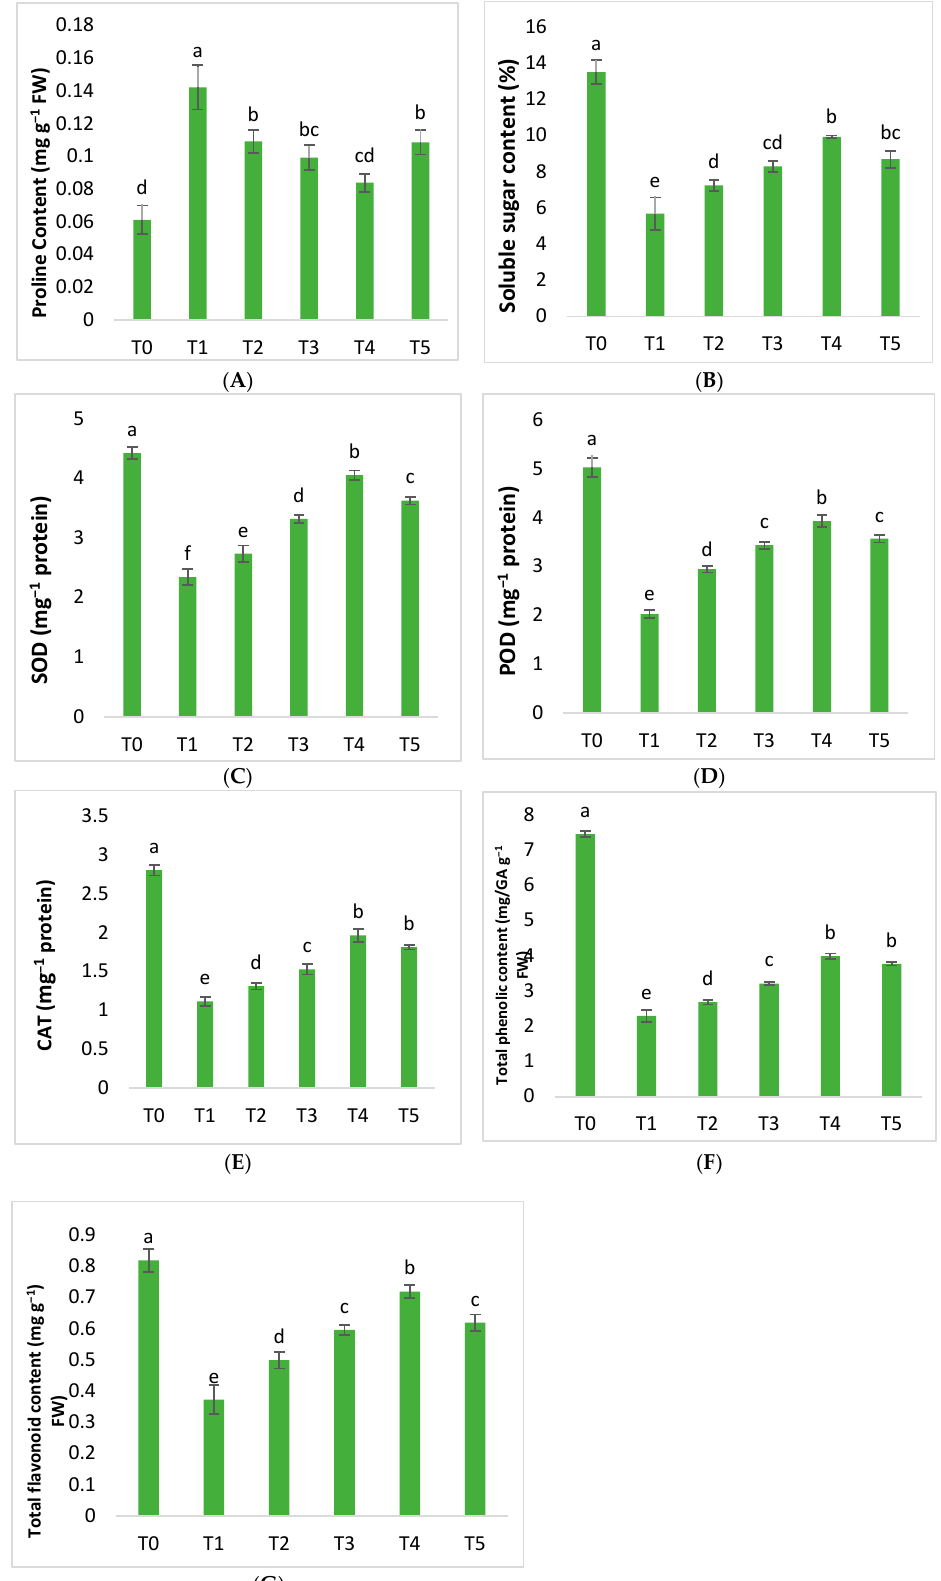
Figure 7. Differential effects of AgNP treatments on the following content: ( A ) proline, ( B ) SSC, ( C ) SOD, ( D ) POD, ( E ) CAT, ( F ) TPC, and ( G ) TFC.